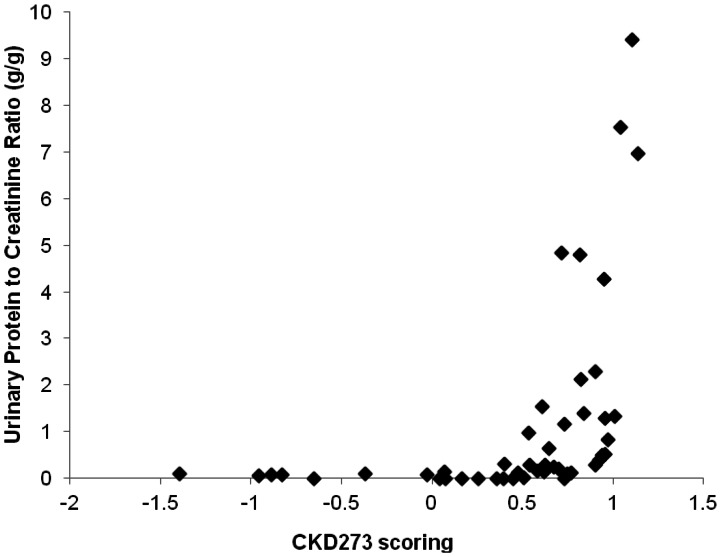
The full urinary proteome/peptidome analysed by CE-MS of selected patients.Patient number 58 (A) and the diabetic patient 27 (B) are shown in the upper panels. These patients had eGFR of 64.3 and 15.7 ml/mn/1.73 m2, respectively. The molecular mass (0.8–20 kDa, on a logarithmic scale) is plotted against normalized migration time (18–45 min). Signal intensity is encoded by peak height and color. The two lower panels show only the peptides that are addressed in the CKD273 model. Differences already visible in the entire proteome become evident when examining the specific biomarkers of the CKD273 classifier.